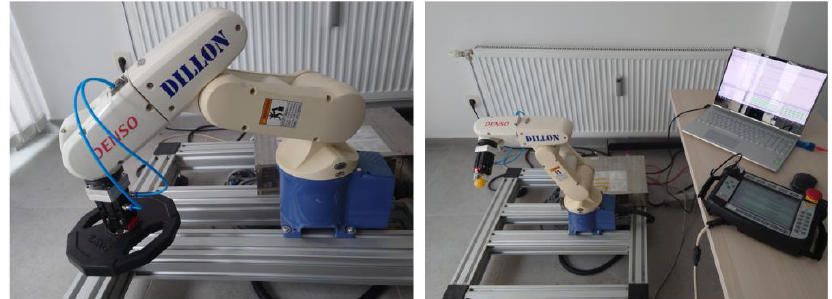
Figure 2. Measurement setups. ( left ) Load manipulation contact task. ( right ) Snap-fit assembly contact